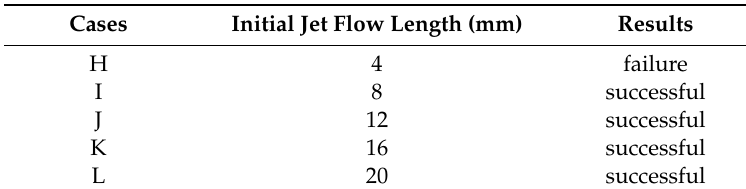
Table 2. Combustor ignition ability under different plasma jet flow lengths.